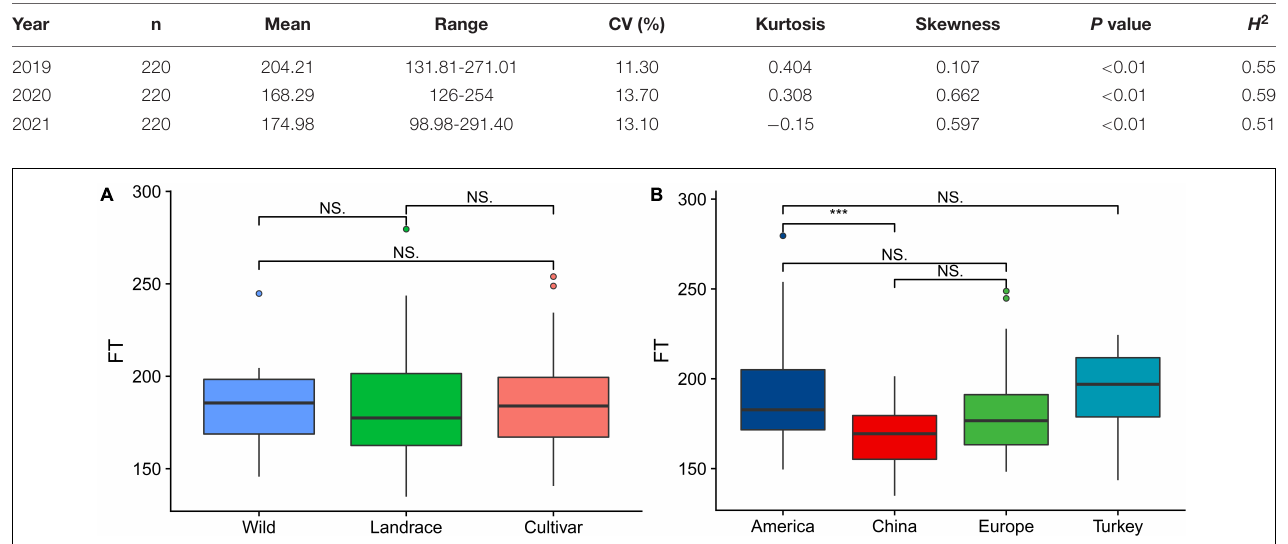
TABLE 1 | Summary statistics of the PTUs of the flowering time in the GWAS population in 2019, 2020, and 2021.